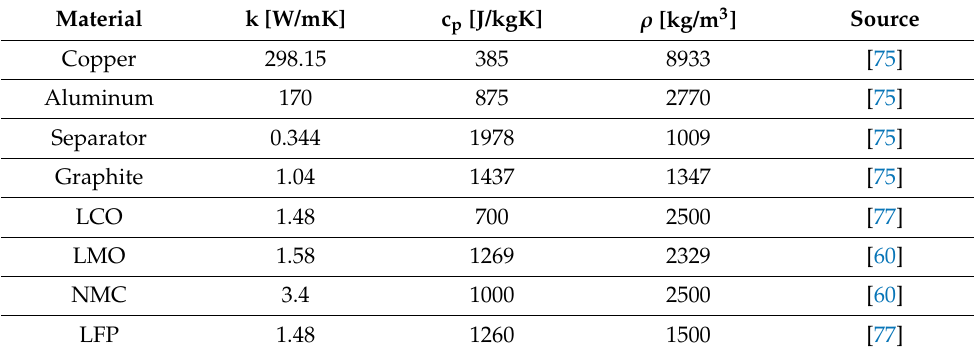
Table 3. Physical properties of cell’s